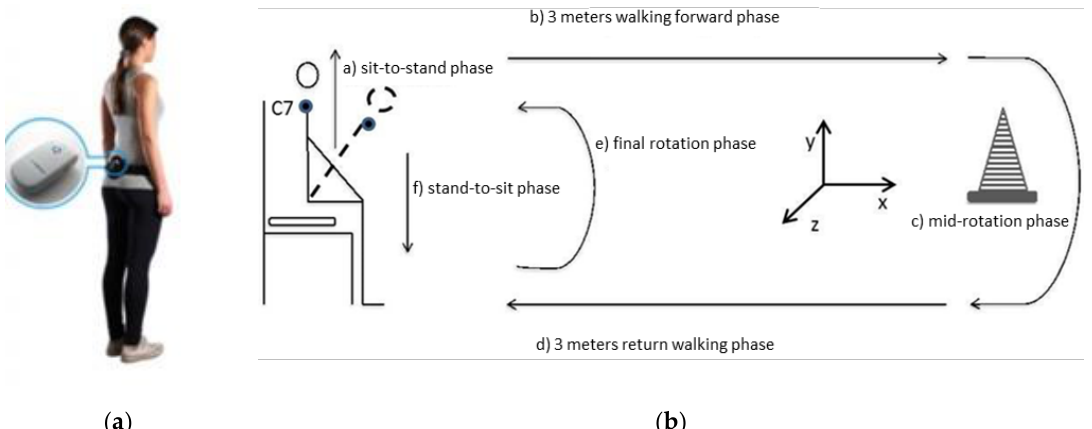
Figure 1. ( a ) Inertial measurement unit (IMU) position and ( b ) timed up and go test (TUG) phases.